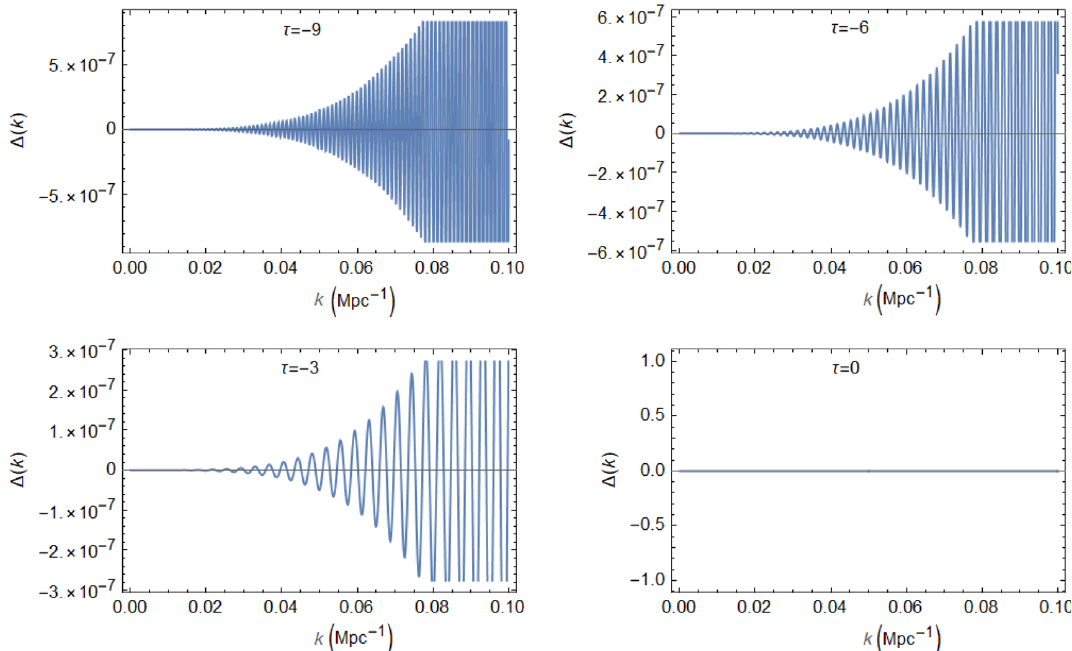
Fig. 3 (cid:16)( k ) vs k using the direct method at four different values of τ